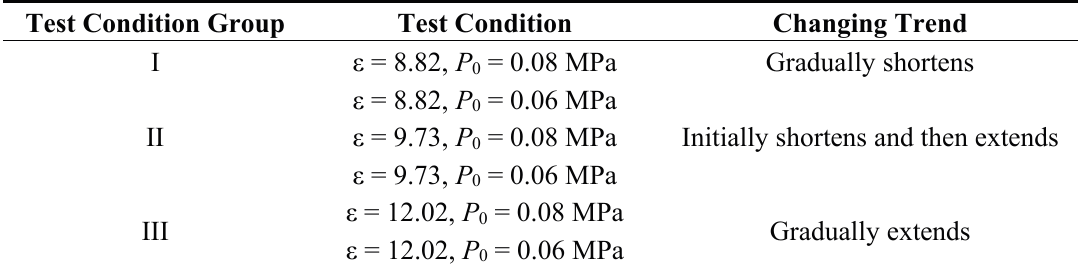
Table 4. Overall ignition delay changing trends with increasing nitrogen dilution